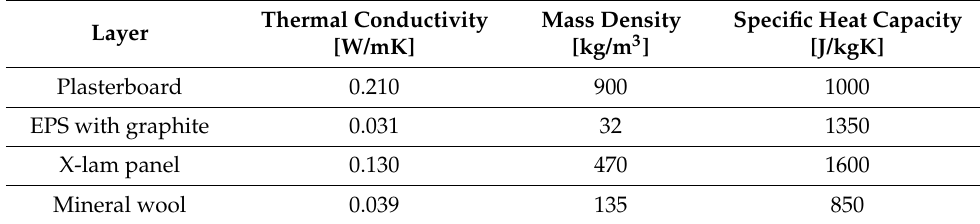
Table 1. Thermophysical properties of the materials used for the specimen wall.